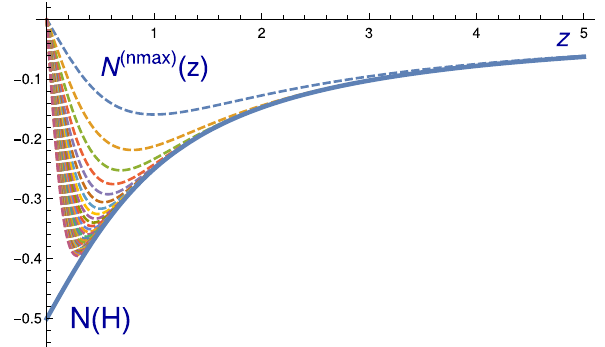
Fig. 1 Partial Sums plotted as functions of μ/ν for increasing values of n